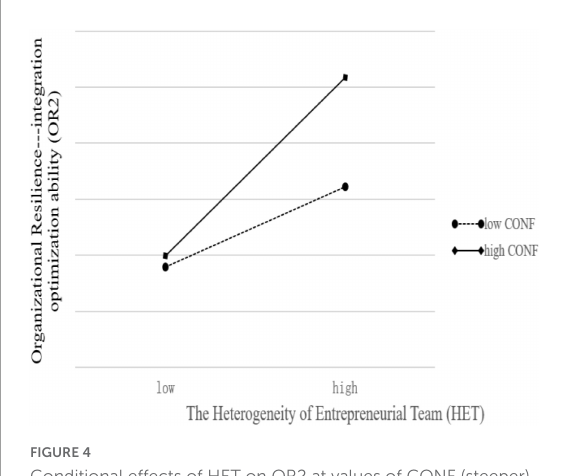
FIGURE4 Conditional effects of HET on OR2 at values of CONF